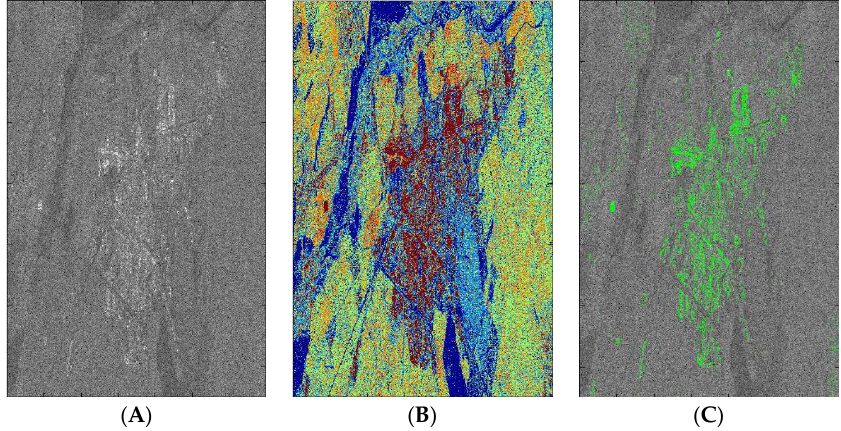
Figure 10. Single-Look ERS image amplitude, Buzau ( A ); Scene classification map presenting categories of evolution ( B ); spatial distribution of detected Persistent Scatterers ( C ).